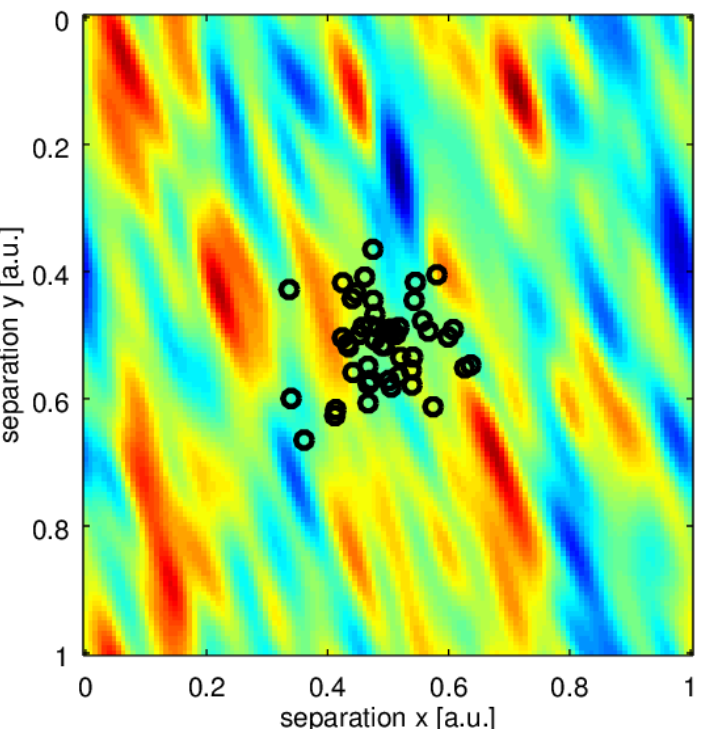
Figure 2. Numerically generated random field and the receiving stations marked as black circles.